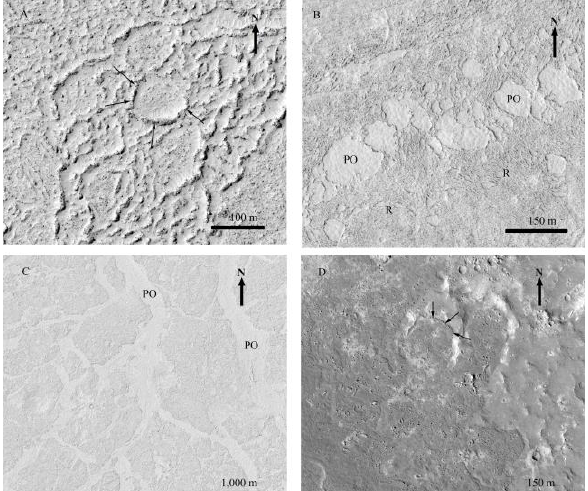
Figure 5. Different detailed morphologies of the PRP terrains in the study area. (A) Circular or irregular ridges developed in the plates (subset of HiRISE image TRA_000854_1855_RED.jp2); (B) Ripple-like plates with embedded smooth polygons (subset of HiRISE image ESP_011759_1850_RED.jp2); (C) Polygons occurring in long strips (subset of HiRISE image ESP_026475_1865_RED.jp2); and (D) Flows with rubbly surfaces filling shallow depressions (subset of HiRISE image ESP_012577_1815_RED.jp2).